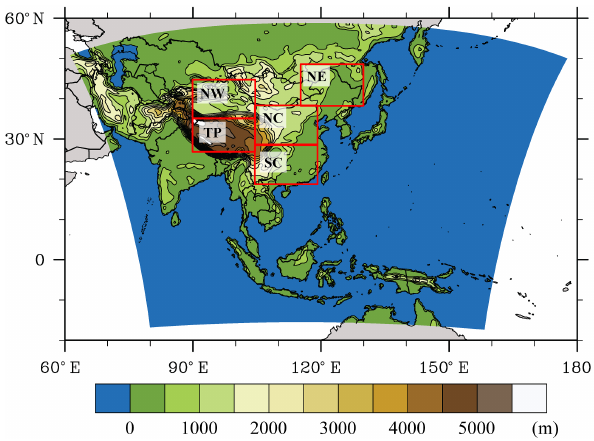
Figure 1. The simulation domain of CORDEX-EA and the topogra- phy of the regional climate models (m). The boxes illustrate the five selected subregions over China: northeastern China (NE), northern China (NC), southern China (SC), northwestern China (NW), and the Tibetan Plateau